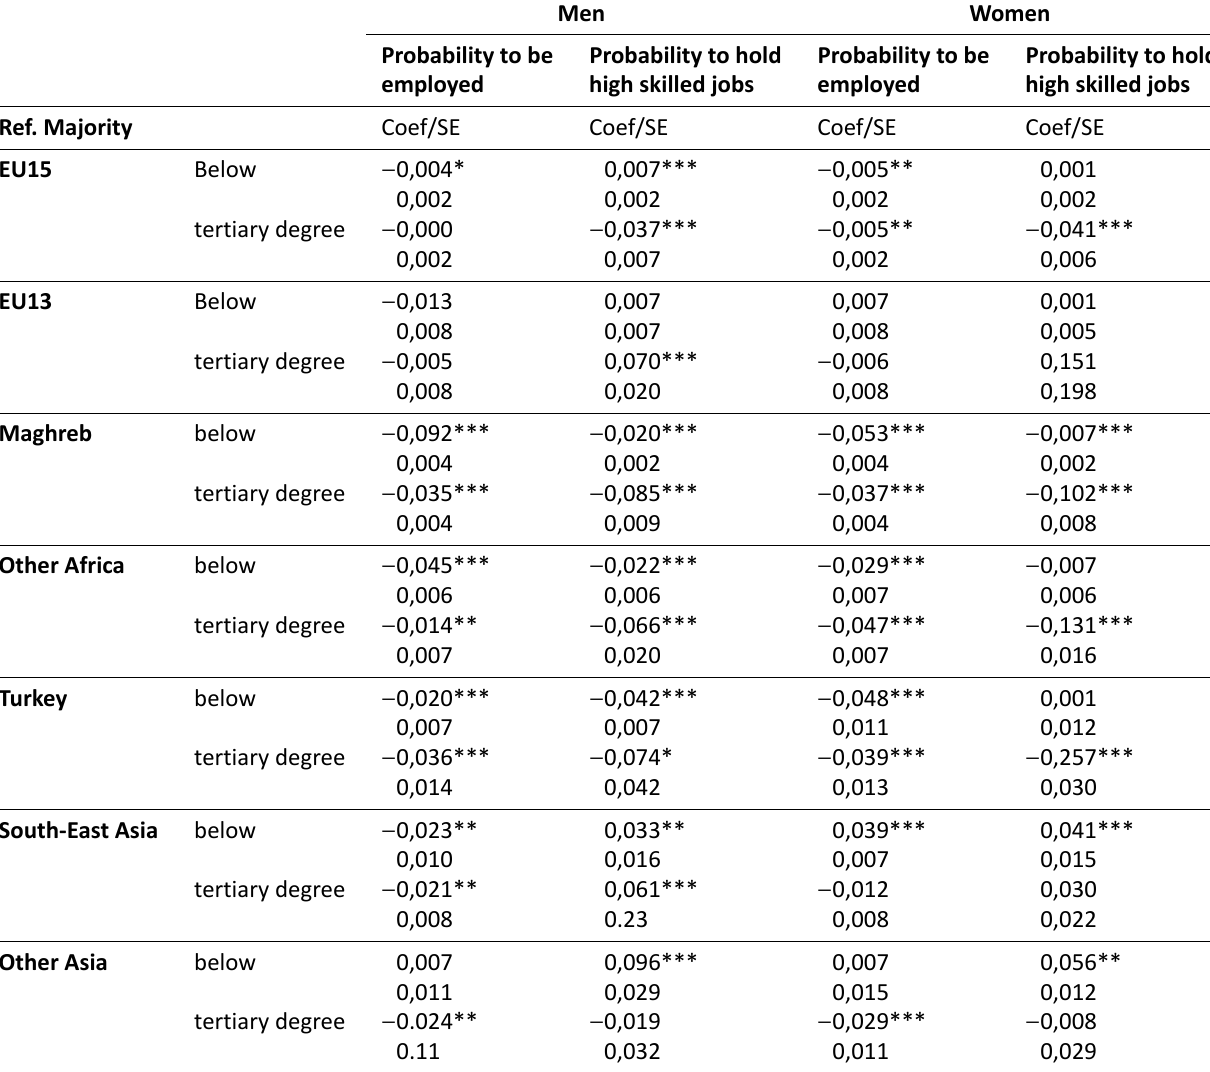
Table 4. Estimated gaps of having post-secondary education (rather than below*) on labour market outcomes for second generation by origin groups and gender. Source: INSEE Labour Force Survey